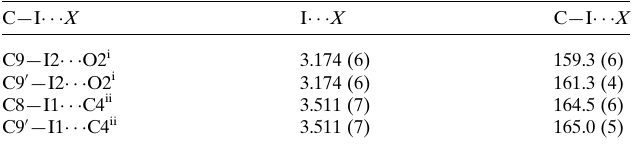
Table 2 Halogen-bond geometry (A˚ , (cid:3) ).